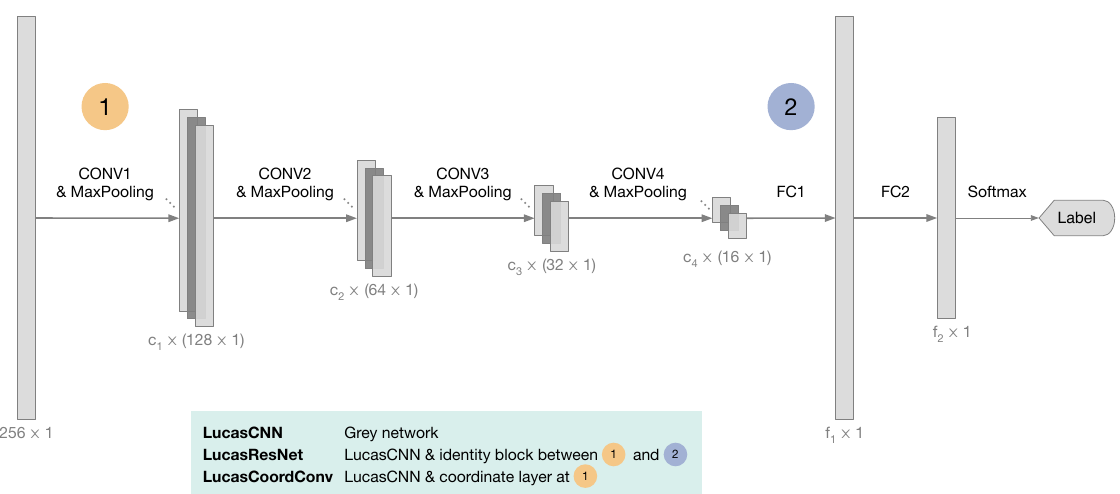
Figure 4. Flowchart of the LucasCNN (grey). The network consist of convolutional (CONV), fully-connected (FC) layers and max- pooling layers. The i -th CONV layer consists of c i filters and the j -th FC layer consists of f j units. For the LucasResNet, an identity block is implemented between the marker 1 and 2 . For the LucasCoordConv, a coordinates layer is inserted before the first CONV layer at marker 1 . At the end of each network, a softmax layer provides the classification output as a 4-dimensional vector. Conv is one coordinates layer placed before the first convolutional layer of the LucasCNN. Liu et al. (2018b) introduced such a coordinates layer first 1 . The network architecture after the first convolutional layer remains the same as in the LucasCNN. The code of all presented implementations of 1D CNNs is published on GitHub (Riese,